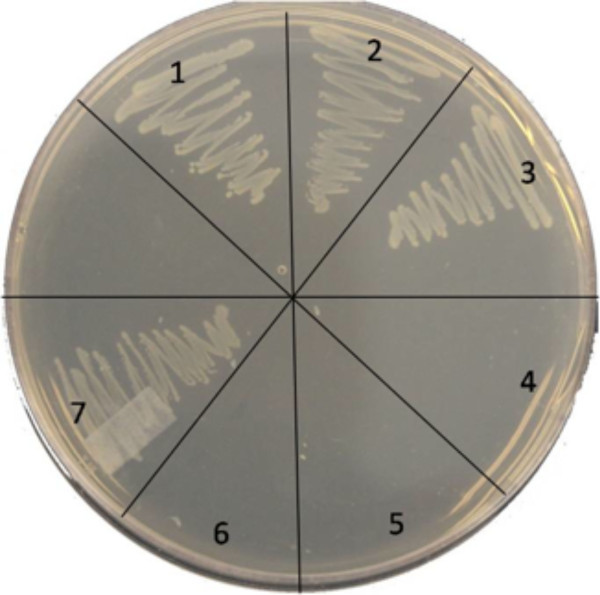
Tkt1 could not complement TktA in E. coli K12. 1, APEC O1; 2, APEC O1 Mtkt1; 3, APEC O1 MtktA; 4, BJ502; 5, BJ502-P1; 6, BJ502-P2 and 7 BJ502-P3.